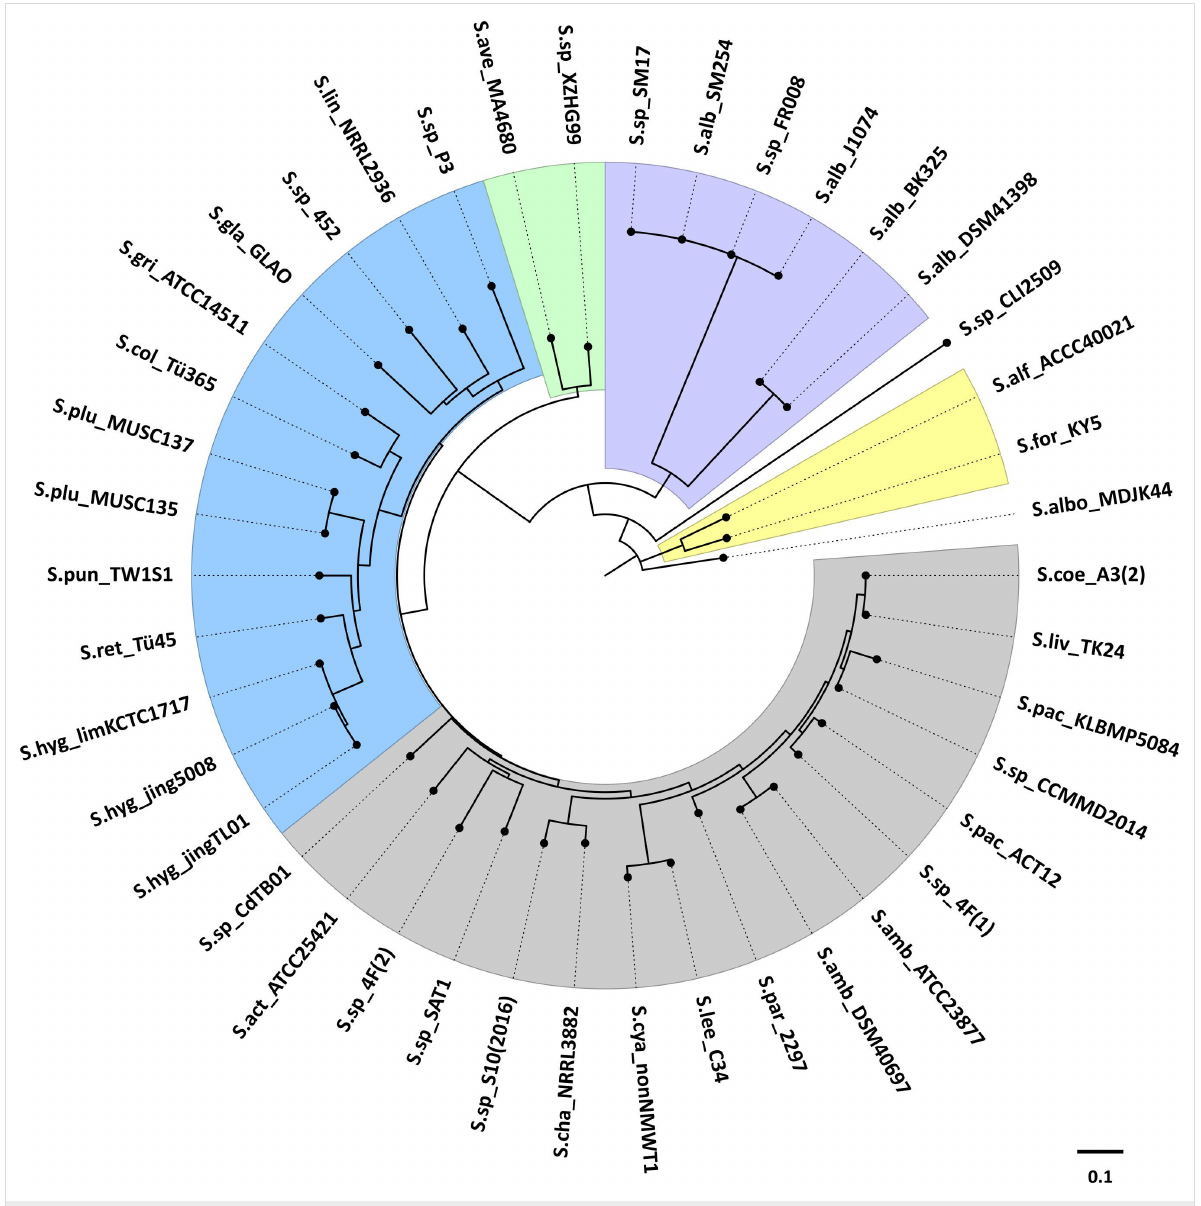
Table S5 (Supporting Information File